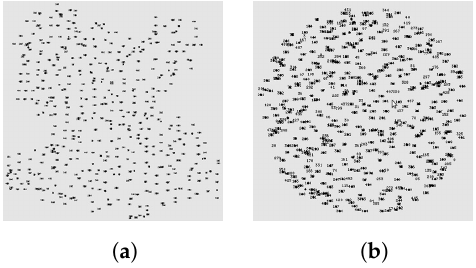
Figure 11. F&C: Disk and irregular network shape. ( a ) Irregular Shape; ( b ) Disk